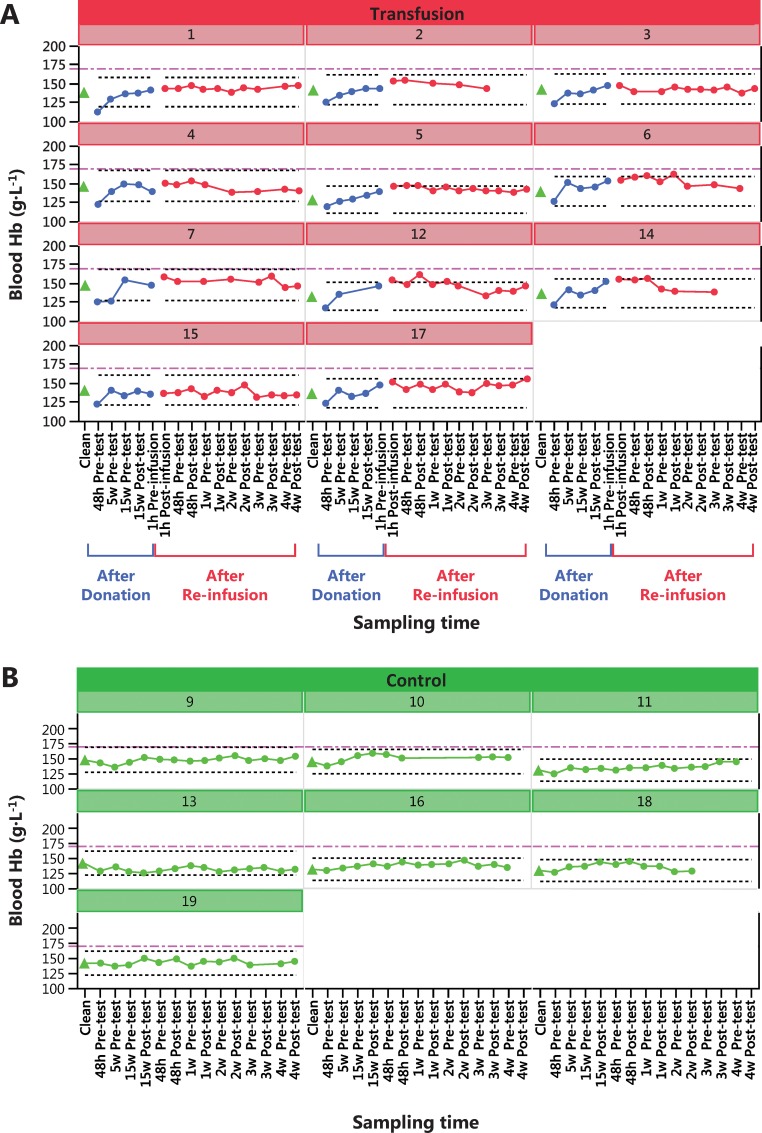
Part A of the Study.Individual blood [Hb] (g·L-1). Results from analysis of 161 blood samples from transfused men (N = 11, Nr 1–17) in Panel A, and 93 samples from control men in Panel B (N = 7, Nr 9–19). All samples were taken in parallel during 22 weeks (Fig 1). Transfused subjects donated two units (900 mL) blood and were re-infused with the washed, cryopreserved RBC fraction at week 17 (Fig 1). Control subjects were sampled and tested at the same time intervals, except no sample was taken at one hour before and after the RBC reinfusion. For reference, a dashed black line at [Hb] ± 15% from the first sample (noted as Clean in both groups) is suggested to be the individual upper and lower limits for indication of autologous blood doping [41]. Upper limit for [Hb] set at 170 g·L-1 for men by some sport federations such as FIS, is indicated by dash-dot purple lines.